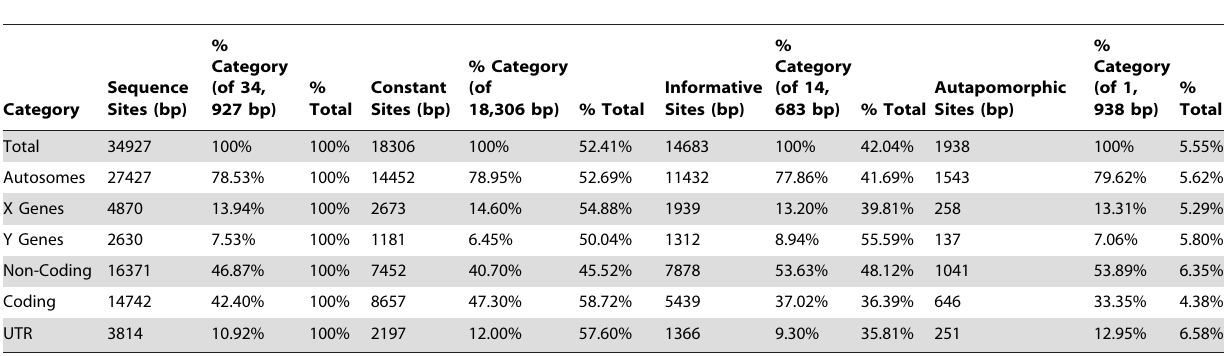
Table 4. Sequence Variation by Gene Category and Data Partition in Primate Phylogeny after Correction For Ambiguous Sites.